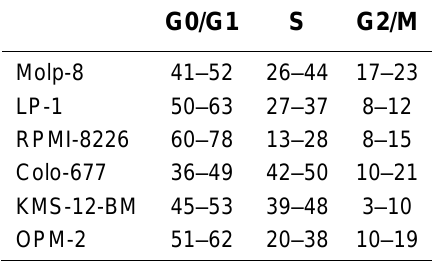
Values of Untreated Human Multiple Myeloma Cells in Different Cell Cycle Phases